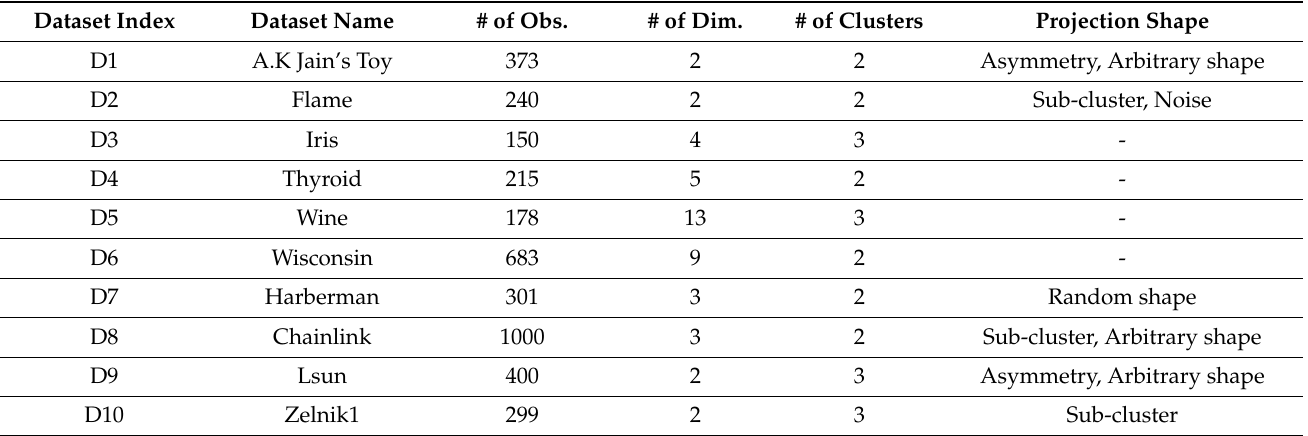
Table 1. Summary of